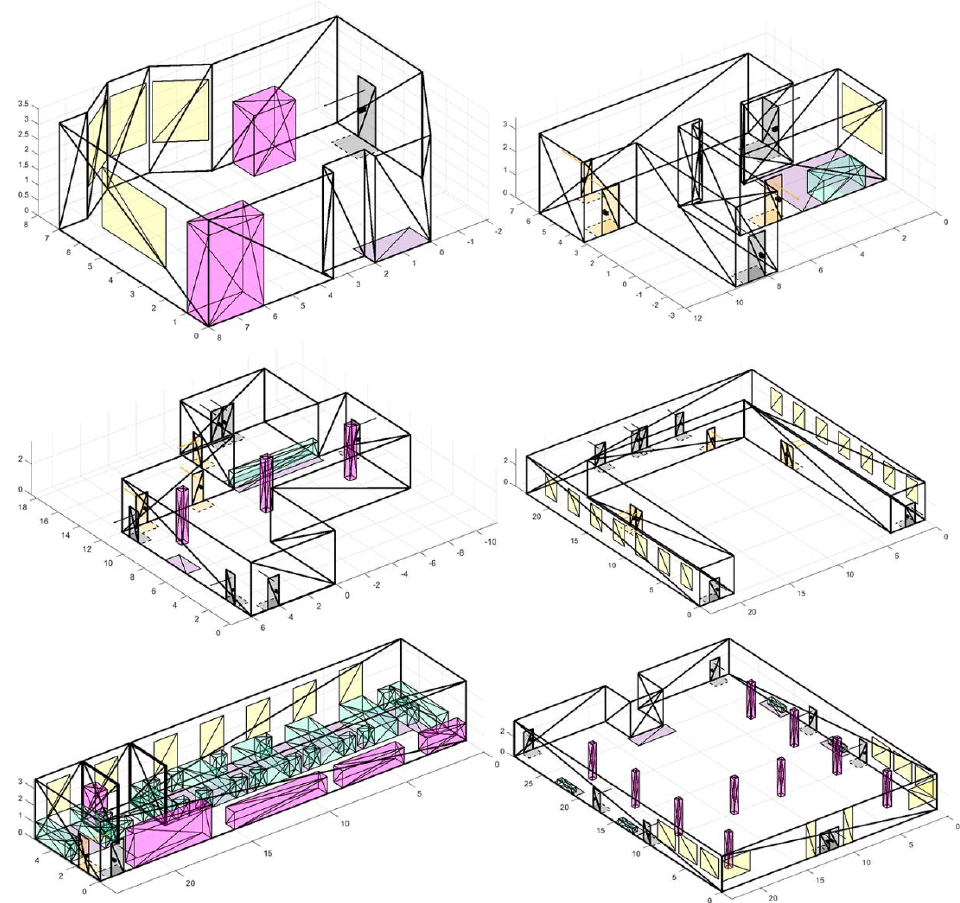
Figure 9. Premises models examples.